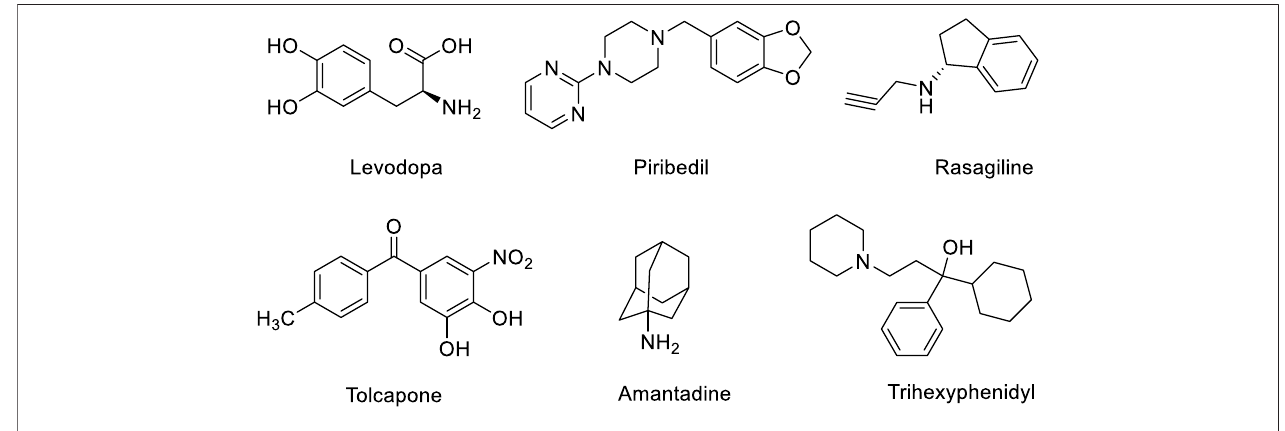
FIGURE 1 | The main therapeutic anti-PD